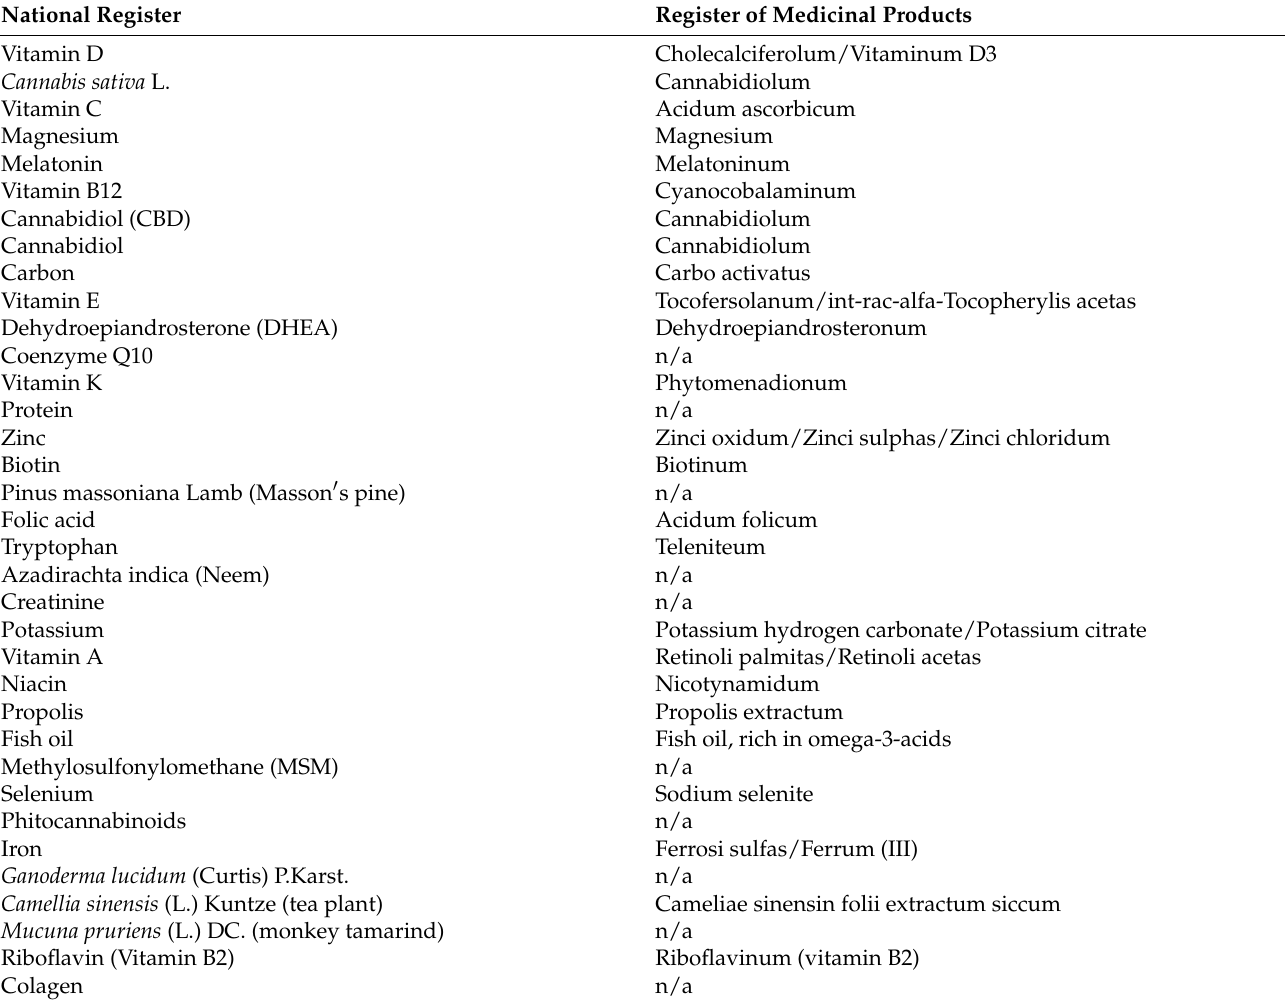
Table 1. Specifications of words upon the basis of which ingredients were classified as